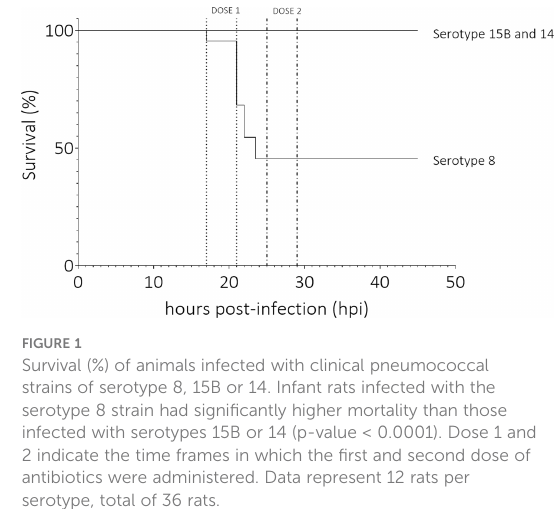
FIGURE 1 Survival (%) of animals infected with clinical pneumococcal strains of serotype 8, 15B or 14. Infant rats infected with the serotype 8 strain had signi fi cantly higher mortality than those infected with serotypes 15B or 14 (p-value < 0.0001). Dose 1 and 2 indicate the time frames in which the fi rst and second dose of antibiotics were administered. Data represent 12 rats per serotype, total of 36